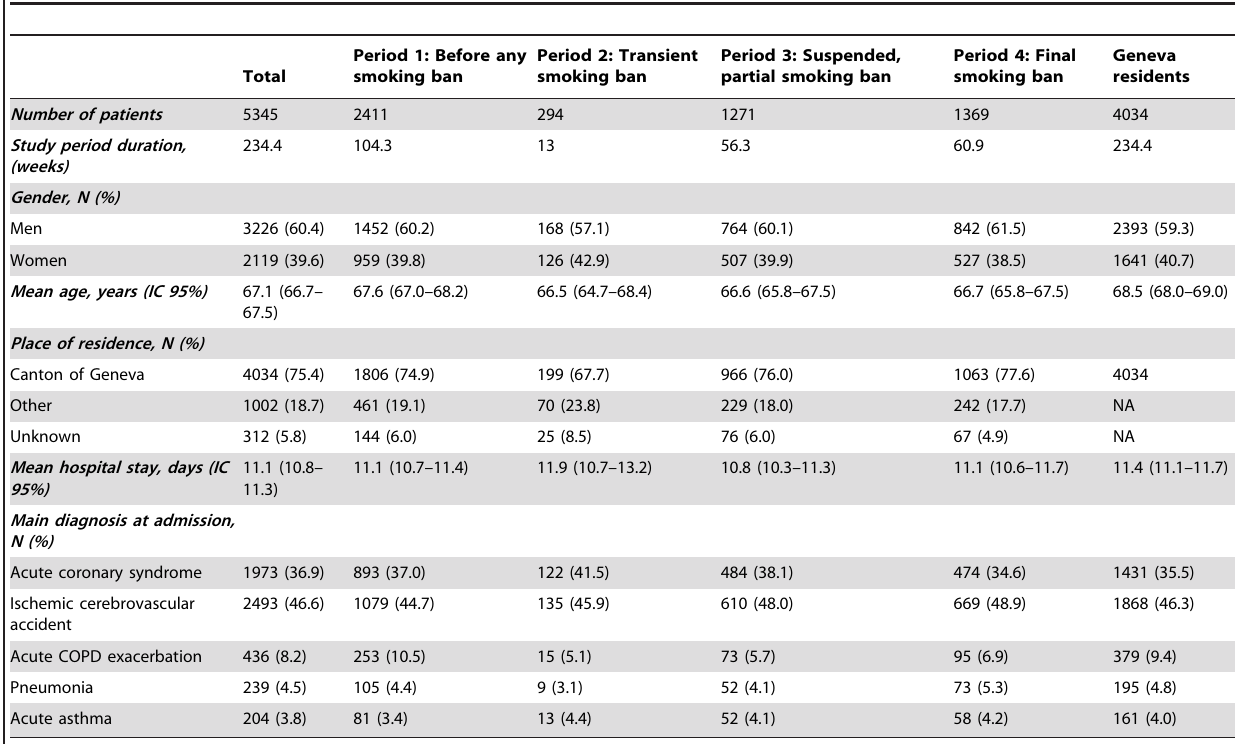
Table 1. Socio-demographic characteristics and diagnoses for hospitalizations for all subjects and Geneva residents.